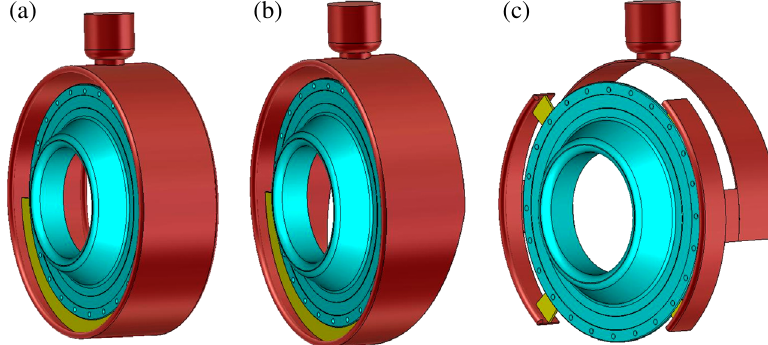
FIG. 2. Schematic of three kinds of azimuthal transmission line high voltage conductors and connecting tabs. (a) The width of high voltage electrode is constant along the power flow direction, and one continuous tab on the lower half circle allows conduction from the azimuthal transmission line to the cathode plate. (b) The width of the high voltage electrode is constant along the upper half circle and gradually decreases on the lower half circle. The pulsed power transmitting from the azimuthal transmission line to cathode plate is also along with the lower half circle. (c) There are two discrete azimuthal transmission lines. The current transmits from the first line to the second line along (cid:3) 80 to (cid:3) 100 degrees. The second line is connected to the cathode plate at four locations extending from (cid:3) 40 to (cid:3) 50 degrees and from (cid:3) 130 to (cid:3) 140 degrees.